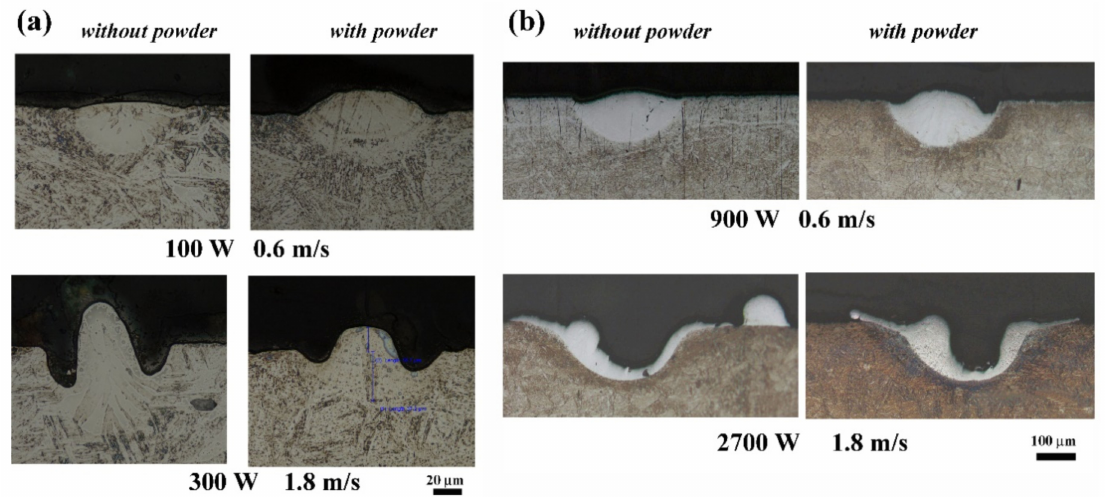
Figure 5. Solidified tracks profiles: ( a ) stable track at P = 100 W, V = 0.6 m/s (top) and expressed humping effect when scanning the substrate and balling effect in LPBF at P = 300 W, V = 1.8 m/s (bottom); ( b ) humping and irregularity at P = 900 W, V = 0.6 m/s (top) and spatter formation at P = 2700 W, V = 1.8 m/s